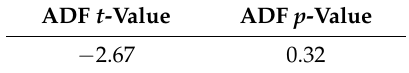
Table 4. Augmented Dicky–Fuller (ADF) statistic of explained percentage variance process.